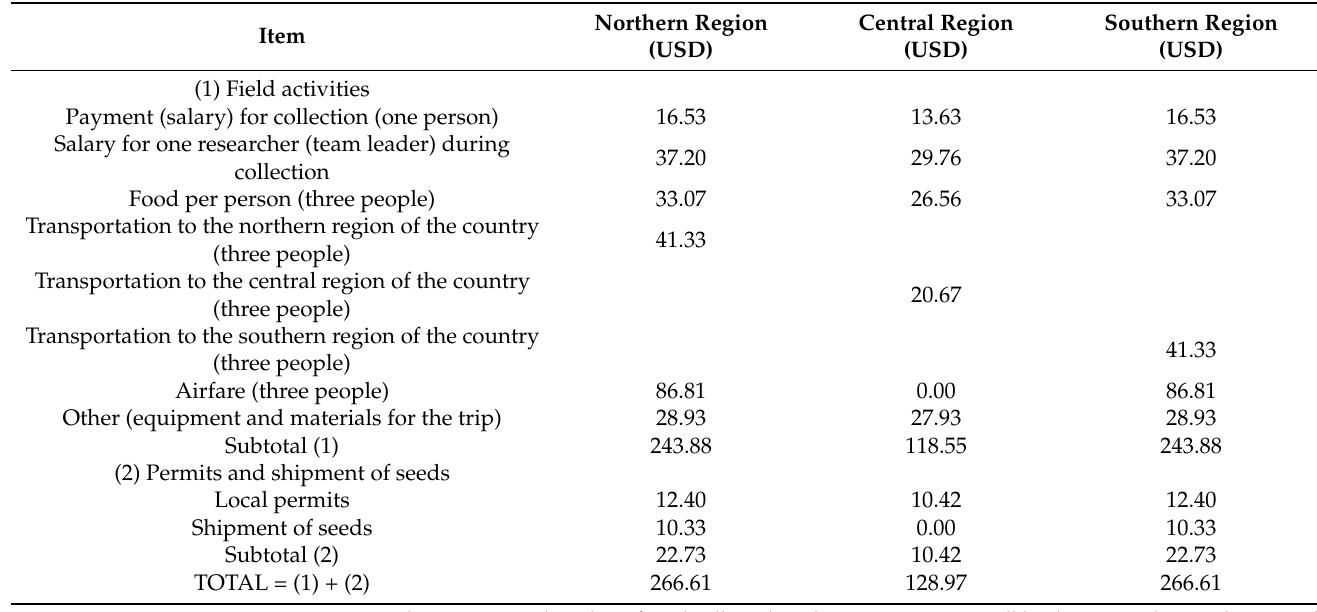
Table 4. Summary of the costs of collection for one accession in US Dollars.